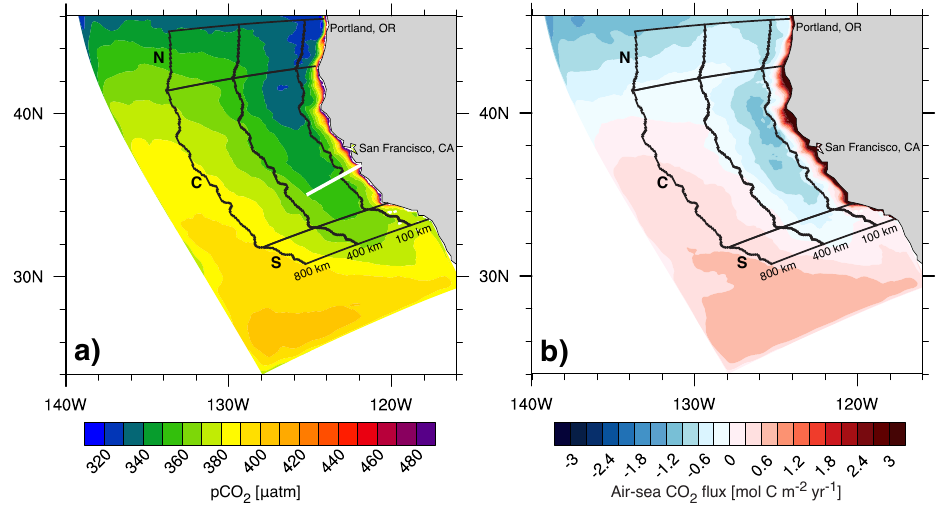
Fig. 1. Annual mean surface p CO 2 (a) and air–sea CO 2 flux (b) as simulated in the CalCS. Positive air–sea fluxes denote an outgassing of CO 2 . The superimposed black lines indicate the nine subdomains, where the northern (N), central (C) and southern (S) subdomains are all split into a nearshore (0–100km), a near-offshore (100–400km) and a far-offshore (400–800km) subdomain. The white line in panel (a) indicates the approximate location of the MBARI/CalCOFI Line